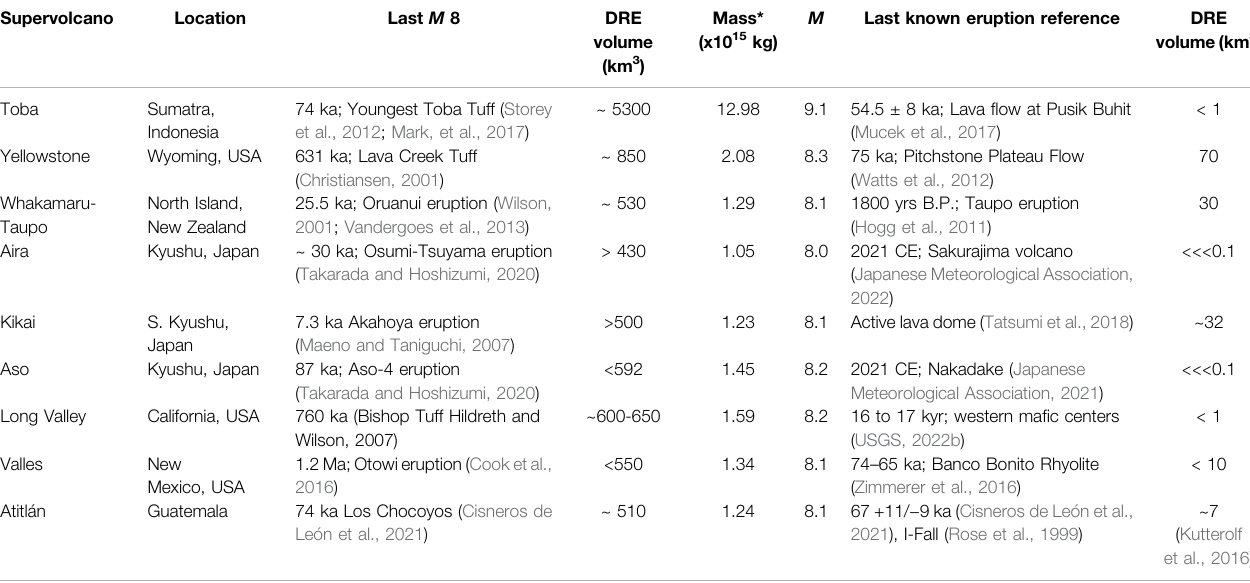
TABLE 1 | Known active † supervolcanoes. † demonstrated eruptive activity < 100 kyrs.